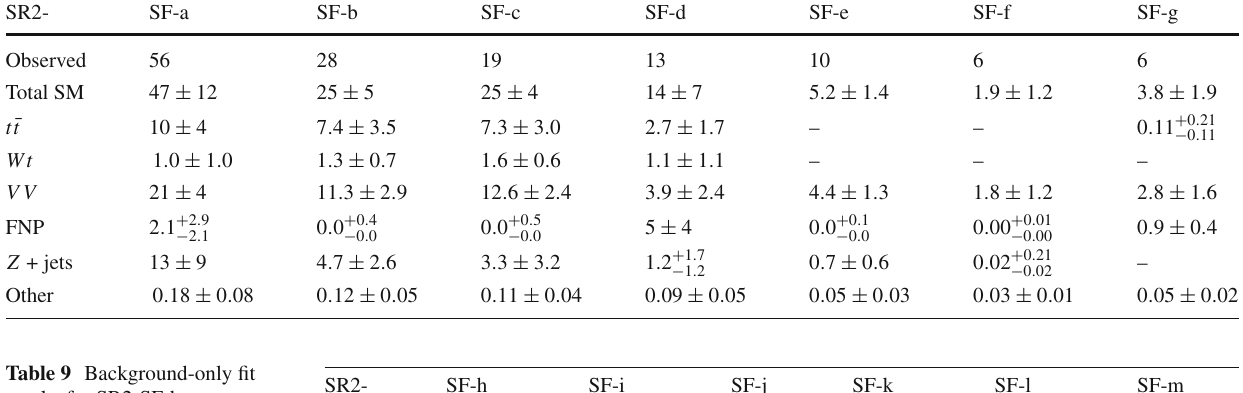
results for SR2-SF-h to SR2-SF-m in the 2 (cid:4) + 0 jets channel. All systematic and statistical uncertainties are included in the fit. The “other” backgrounds include all processes producing a Higgs boson, V V V and t ¯ tV . A “–” symbol indicates that the background contribution is negligible